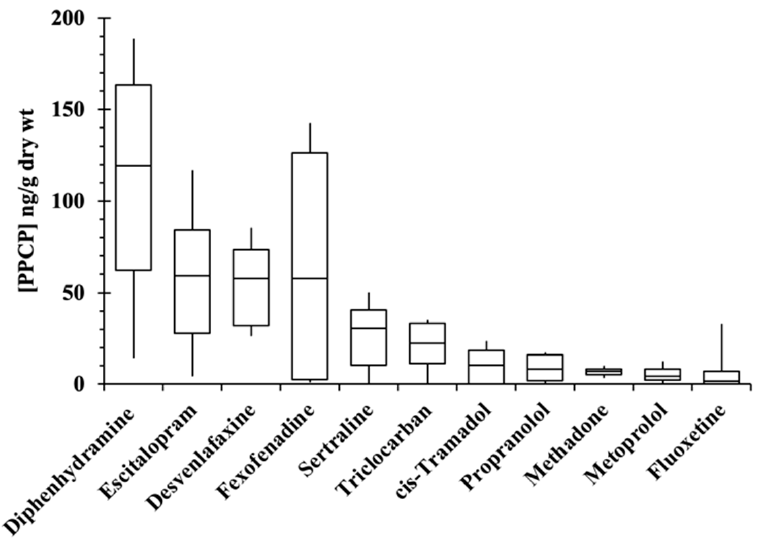
Figure 3. PCA loadings plot of PPCP composition across all tidal freshwater Potomac River sam- pling sites.